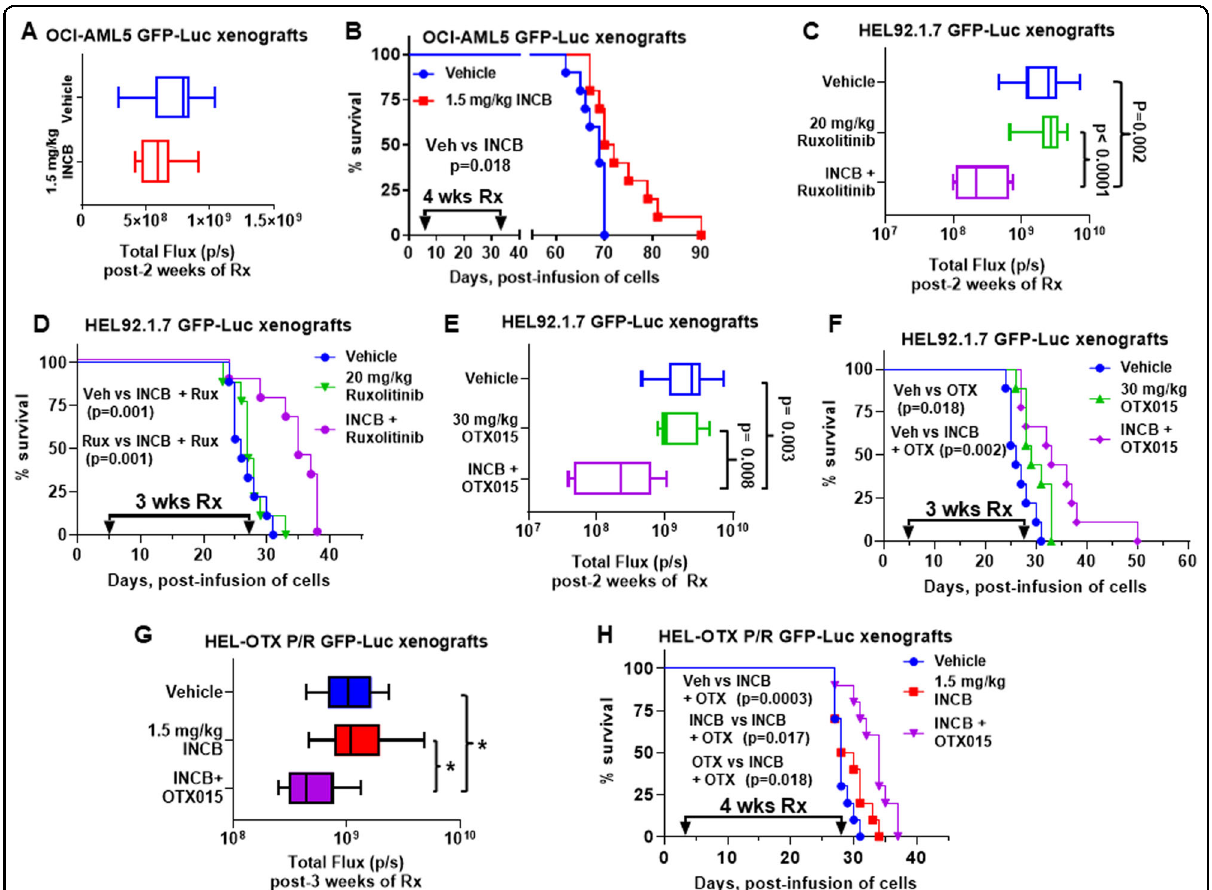
and treated for 2 weeks with INCB059872. B Kaplan – Meier survival plot of NSG mice engrafted with OCI-AML5 GFP-Luc cells and treated with 1.5 mg/ kg of INCB059872 (daily x 5 days, P.O.) for 4 weeks. Signi fi cance was calculated by a Mantel – Cox log-rank test. C Total photon counts [ fl ux] in NSG mice engrafted with HEL92.1.7 GFP-Luc cells and treated for 2 weeks with INCB059872 and/or ruxolitinib. D Kaplan – Meier survival plot of NSG mice engrafted with HEL92.1.7 GFP-Luc cells and treated with 1.5 mg/kg of INCB059872 (daily x 5 days, P.O.) and/or 20 mg/kg of ruxolitinib (daily x 5